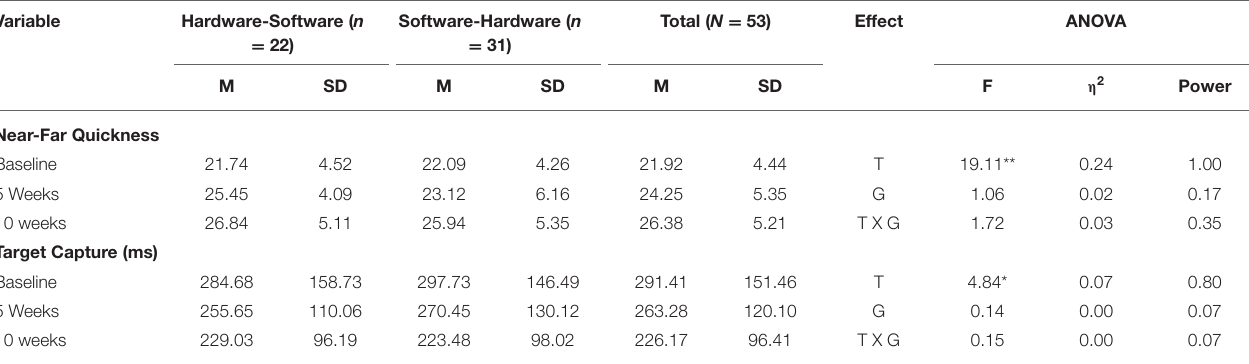
TABLE 3 | Means, Standard Deviations, and Two-way ANOVA statistics for Eye Quickness Variables. Variable